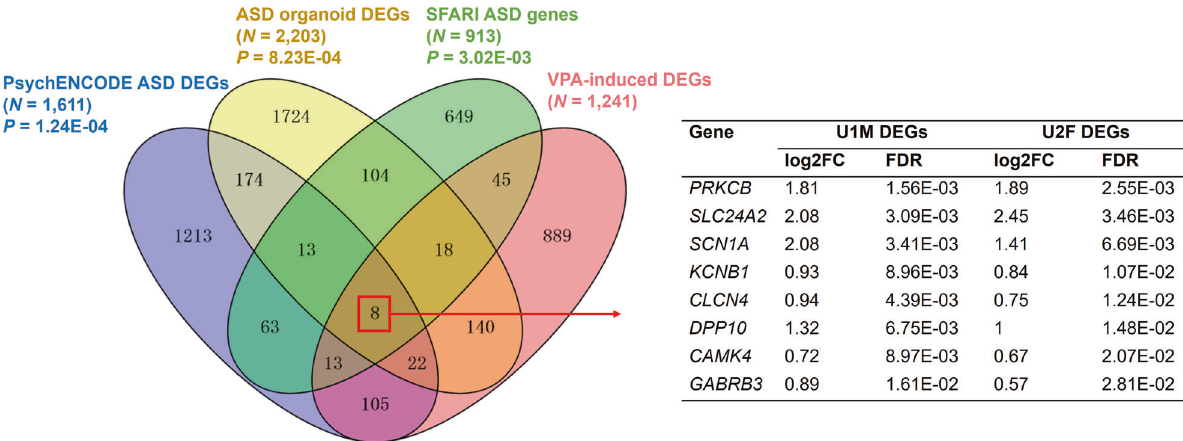
Fig. 2 Enrichment of 1241 shared VPA-induced DEGs with ASD risk-associated gene sets. Veen Diagram shows the overlap among VPA- induced DEGs and three sets of ASD-associated genes. The hypergeometric test was used to assess the enrichment between VPA-induced DEGs and ASD-associated gene sets. P values of the hypergeometric tests are indicated. Eight DEGs shared in all the gene sets are shown. FC fold change, FDR false discovery